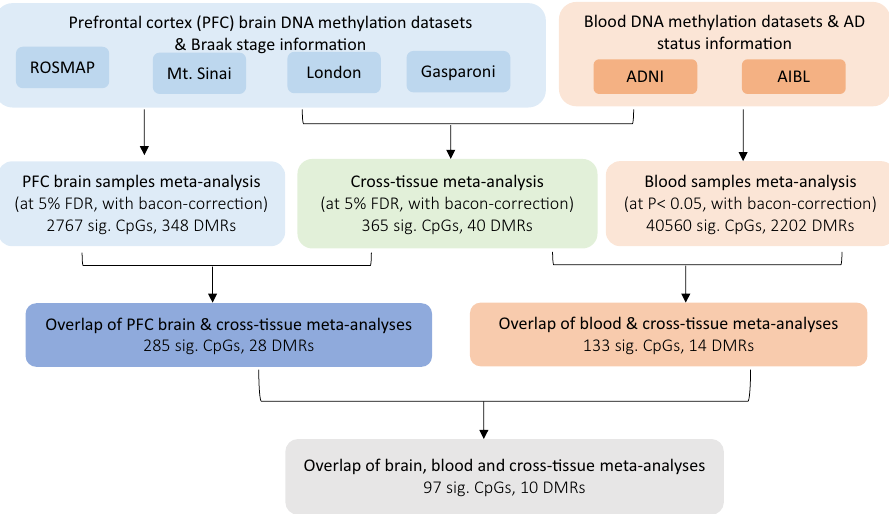
Fig. 2| Work fl owforidentifyingcross-tissueDNAmethylationdifferencesthat are associated with both AD pathology (in prefrontal cortex brain samples) andADdiagnosis(inbloodsamples). Genomiccorrectionswereperformedusing